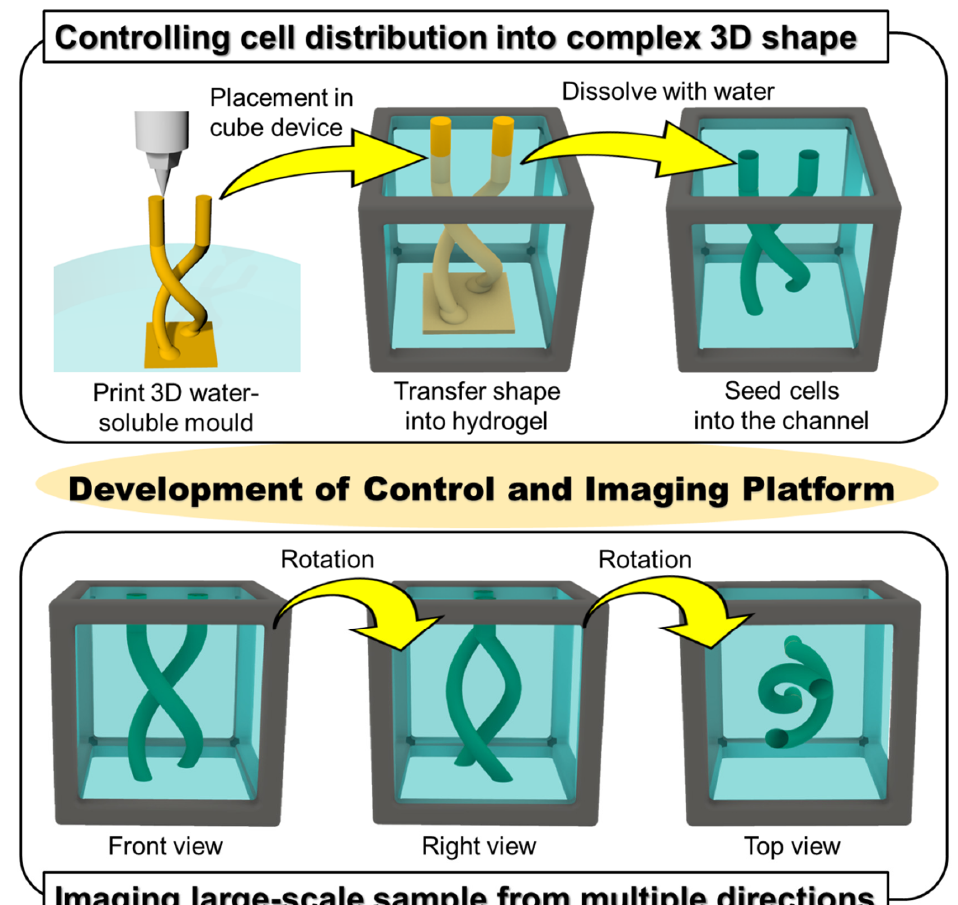
Figure 1. Conceptual images of 3D culture platform to enable the control of cell distribution into complex shapes and large-scale imaging. Water-soluble material (carbohydrate glass) allows us to fabricate complex-shaped molds and cells can be seeded in the channel developed by the mold in a cube device. The cube allows us to scan from multiple directions by rotating the cube so that large-scale imaging can be achieved.